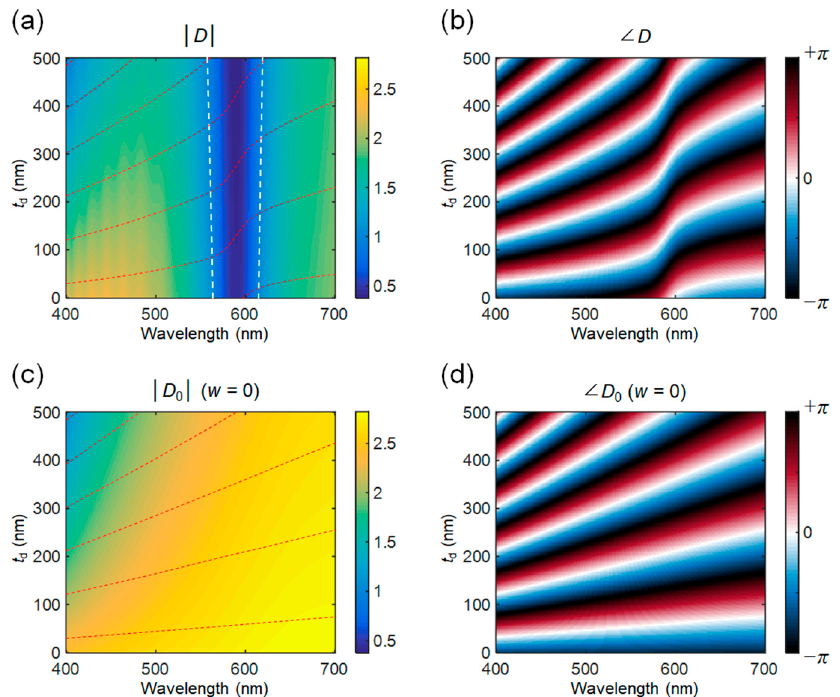
Figure 7. Plots of ( a ) magnitude and ( b ) phase of D ( t d , λ ) defined in Equation (3) in order to investigate the critical coupling condition for perfect absorption. ( c ) and (d) show the corresponding results for the case of a flat Al reflector without the grating structure ( w = 0). In ( a , c ), white- and red-colored dashed lines indicate where the magnitude is 1 and the phase is 2 π m ( m is an integer), respectively.